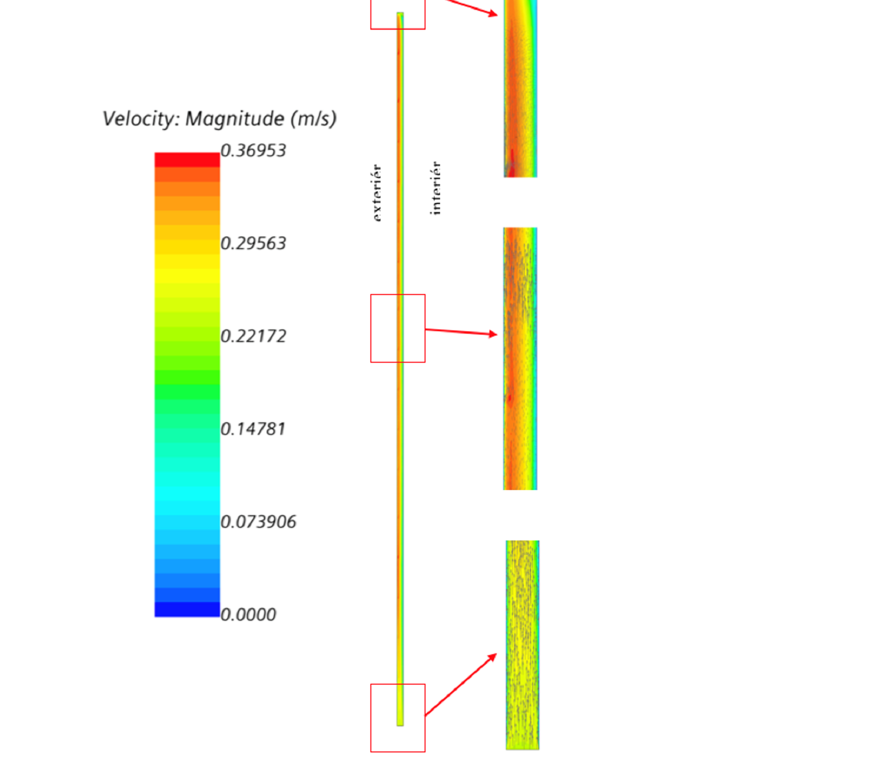
Figure 11. Visualization of velocity field in air gap in façade vertical cross-section summer extreme.